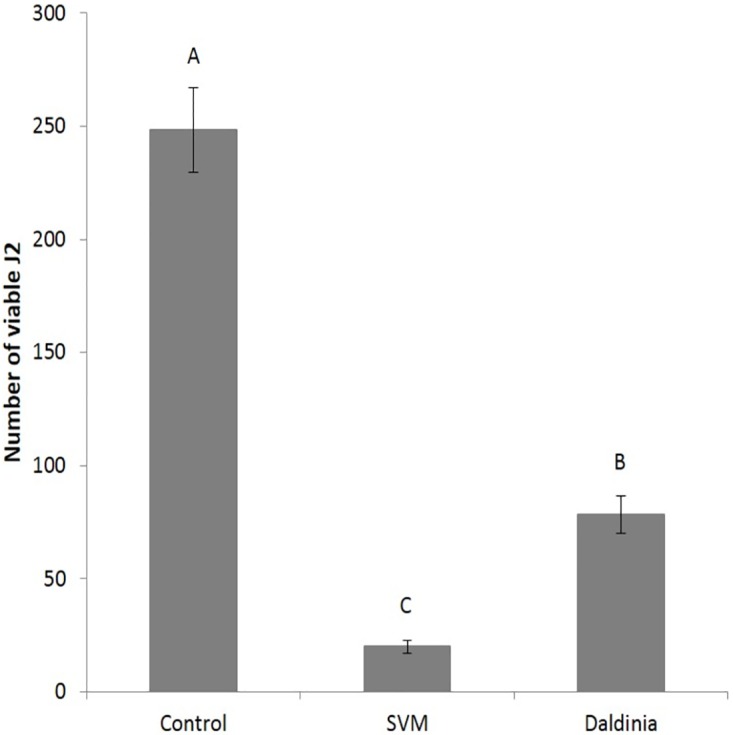
Effect on M. javanica J2 viability of a SVM compared with that of D. cf. concentrica culture.J2s were exposed for 48 h either to the SVM at 1 mL/L (V/V) [3-methyl-1-butanol (0.2 mL, 1.84 mmole), (±)-2-methyl-1-butanol (0.2 mL, 1.86 mmole), 4-heptanone (0.4 mL, 2.86 mmole), and isoamyl acetate (0.2 mL, 1.35 mmole)] or to three 50-mm-diameter fungal culture plates, each with 5 mL of growth medium, and then the viable J2s were separated using 30 μm sieves. The numbers on the y-axis represent the numbers (mean ± SE) of viable J2s counted following the incubation. Each treatment was composed of 10 technical repetitions using 300 J2s in each repetition. The results were subjected to analysis of variance followed by the Tukey-Kramer multiple comparison test; different letters above the bars indicate a significant difference between samples at P ≤ 0.05. The experiment was independently repeated three times, each time with similar results.